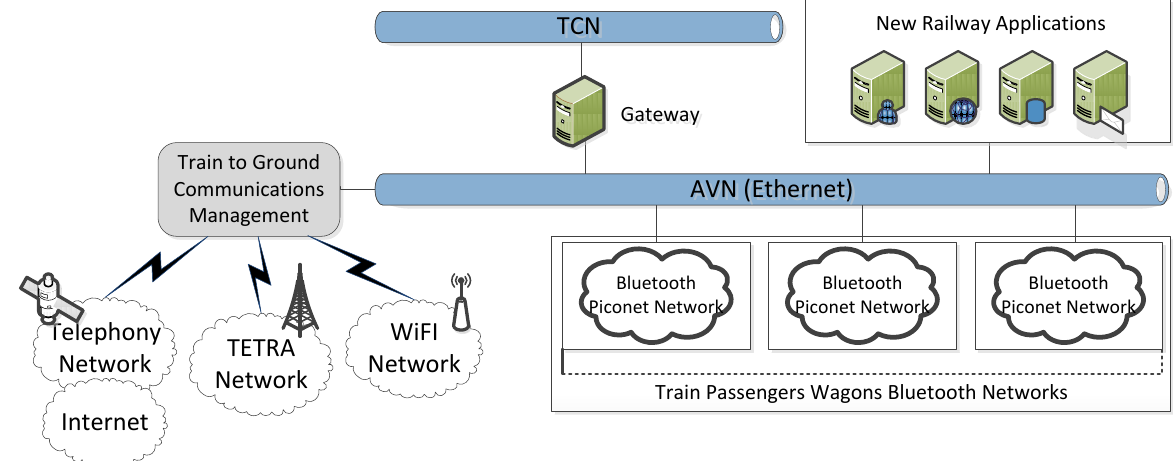
Figure 1. Network architecture of the ubiquitous connected